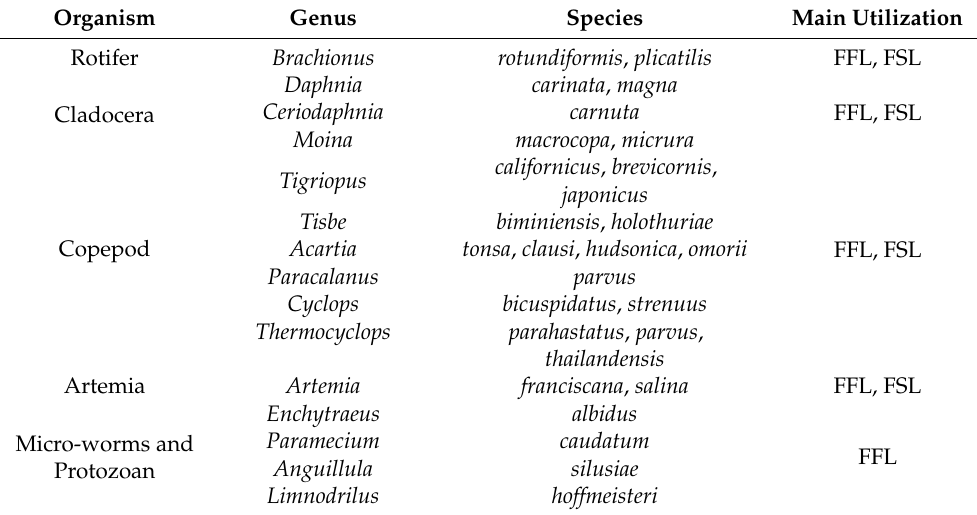
Table 2. Zooplankton and micro-worms most used as live food in aquaculture. FFL: food for fish larvae; FSL: food for shrimp larvae. Source: modified from Silva et al.